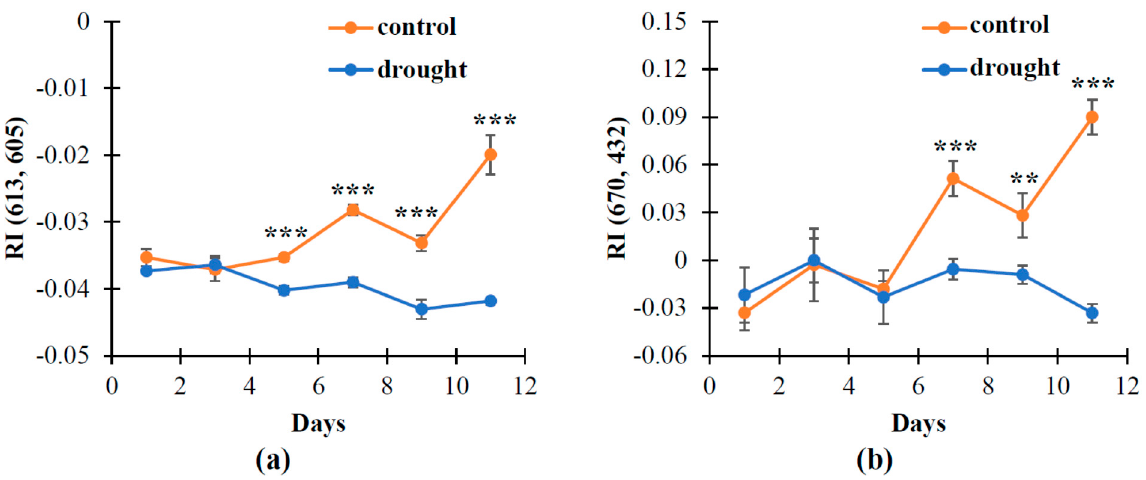
Figure 8. The influence of soil drought on RI (613, 605) ( a ) and RI (670, 432) ( b ) in wheat under open-ground conditions. Only the side view was used for hyperspectral measurements. * p < 0.05; ** p < 0.01; *** p < 0.001.